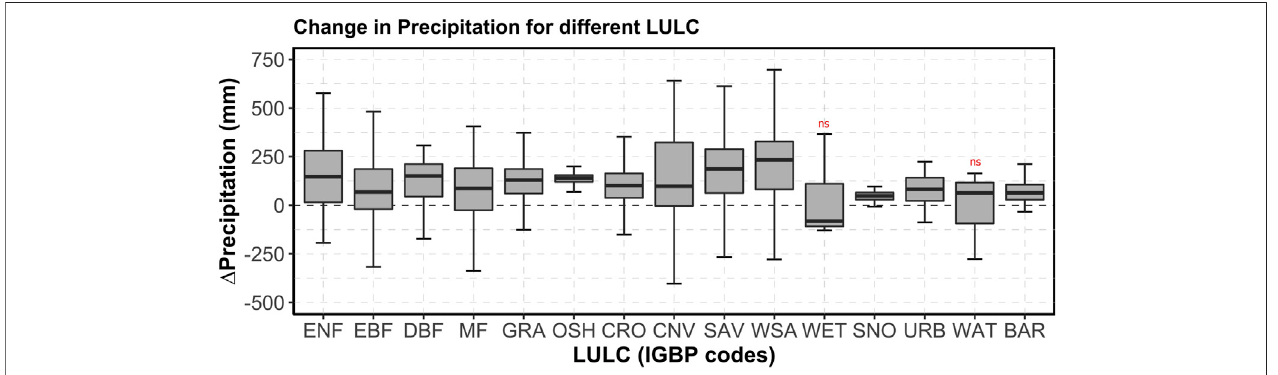
FIGURE 9 | Mean changes in precipitation (2015 – 2002) across different land-use/land-cover (LULC) types. The LULC is shown as International Geosphere- BiographProgram(IGBP) codesof land cover. The “ ns ” above the error-point denotes that the mean and median change wasnot signi fi cantly different from zero asper t -test and Wilcoxon rank sum test, respectively. The error bar shows the standard deviation of all the data